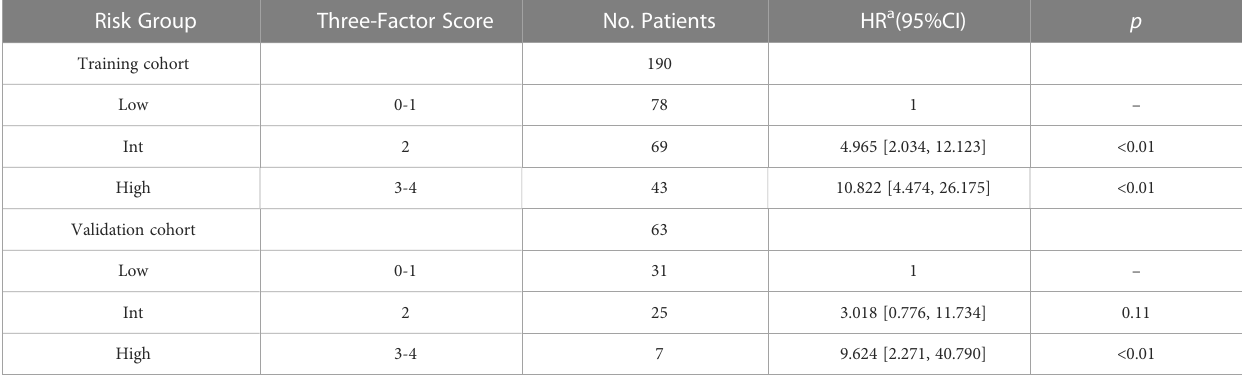
TABLE 5 Survival of the clinical risk groups strati fi ed by the three-factor model.